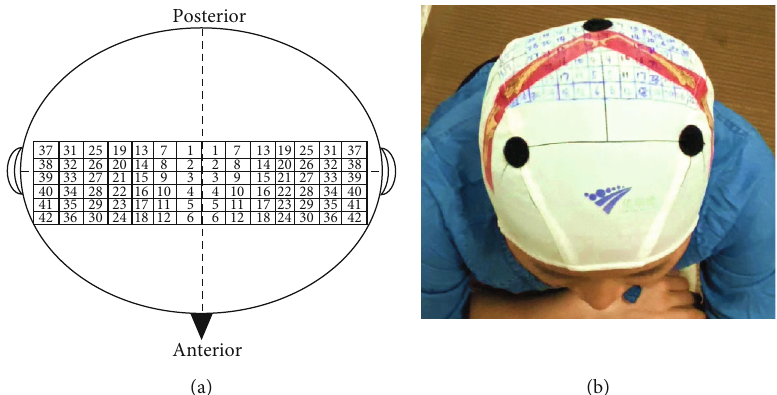
Figure 1: The standard 1 × 1cm grid cap. (a) Schematic diagram. L: 6 × 7 cm grid; R: 6 × 7 cm grid. (b) Rendering fi gure. The red band is the primary motor cortex. The two black dots on the ventral side are the left and right dorsolateral frontal lobes. The black dot on the dorsal side is at 1 cm behind the central zero